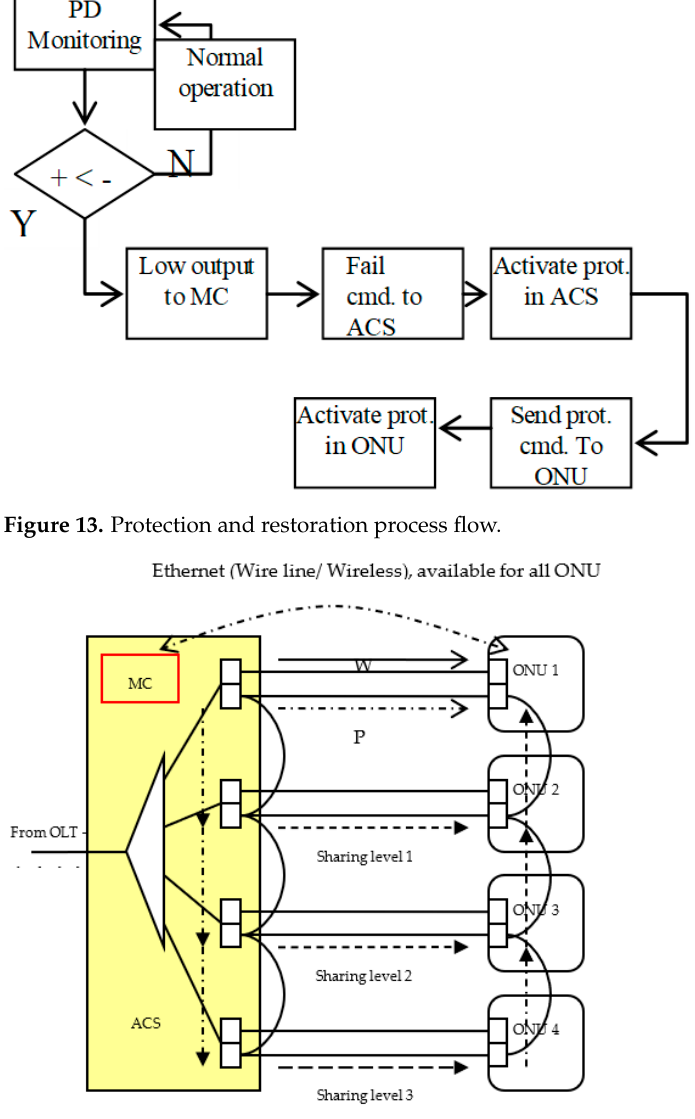
Figure 14. ACS and PROMO as a protection and restoration solution.